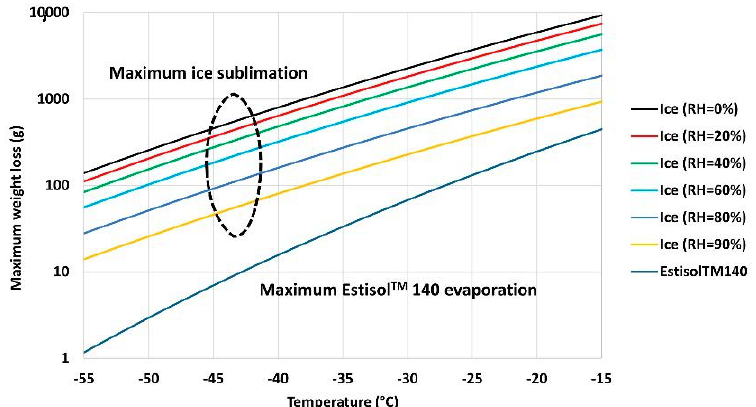
Figure 2. Maximum ice sublimation and Estisol TM 140 evaporation after one week ventilation at 40 m 3 /h as a function of the temperature and relative humidity of the inlet air. If, as assumed, the air is collected from a hole in the ice the relative humidity is 100% and the ice loss goes to zero.